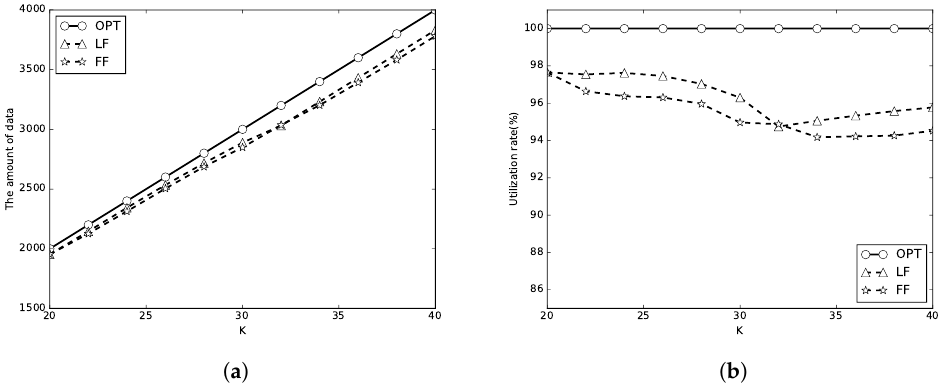
Figure 5. C = E . ( a ) the amount of data; ( b ) energy utilization rate.